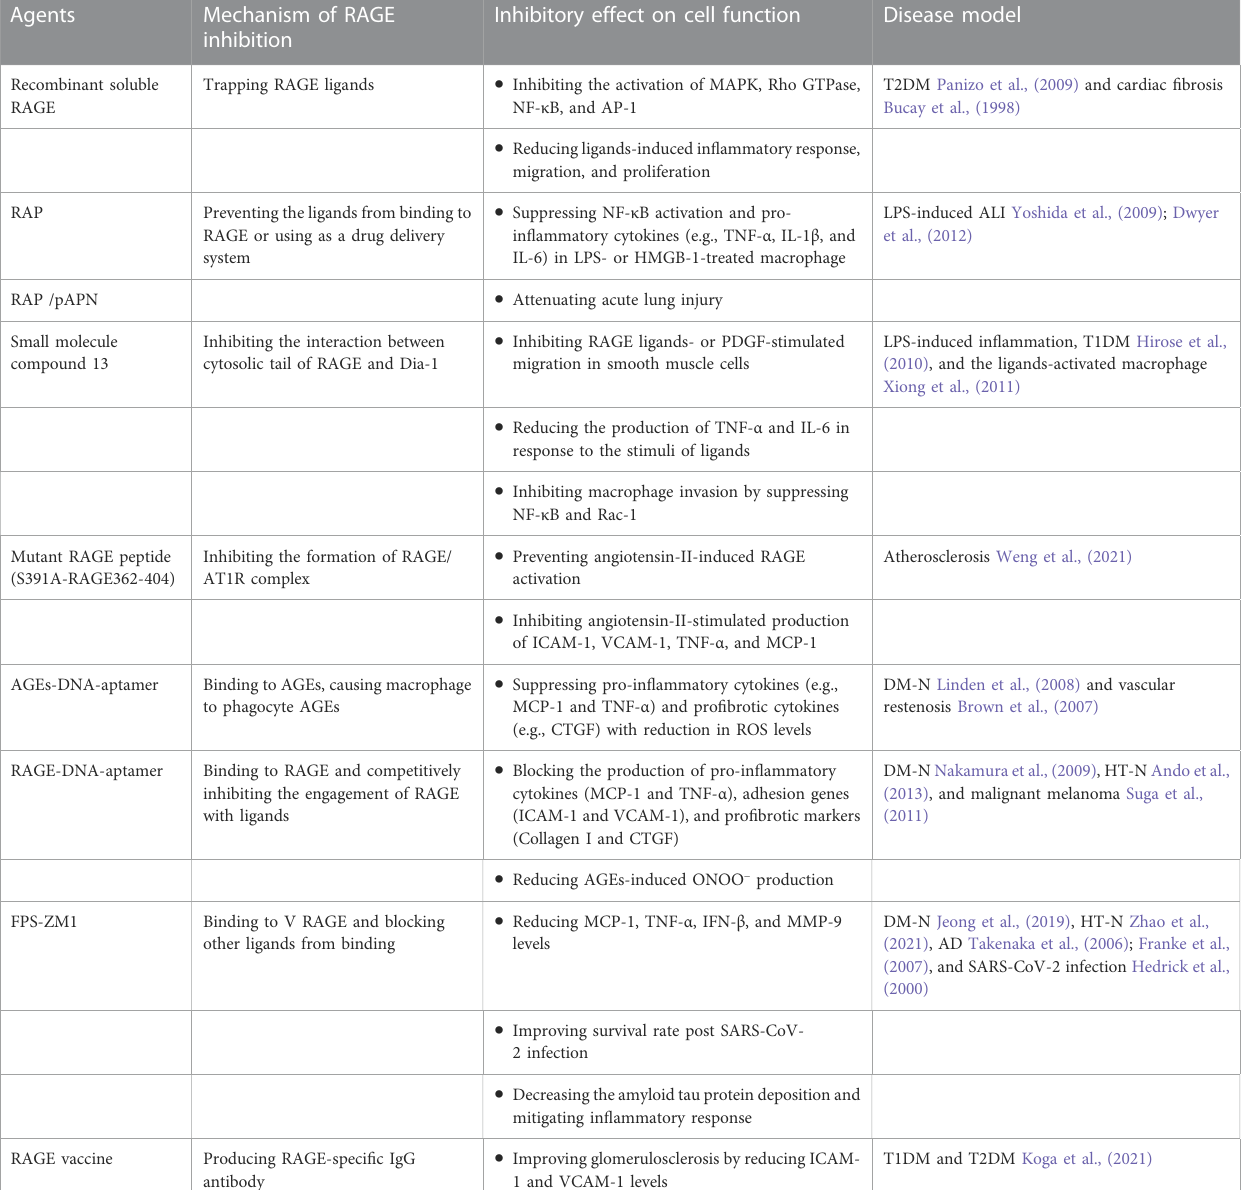
TABLE 1 Characteristics of the latest RAGE-targeting therapeutic agents.